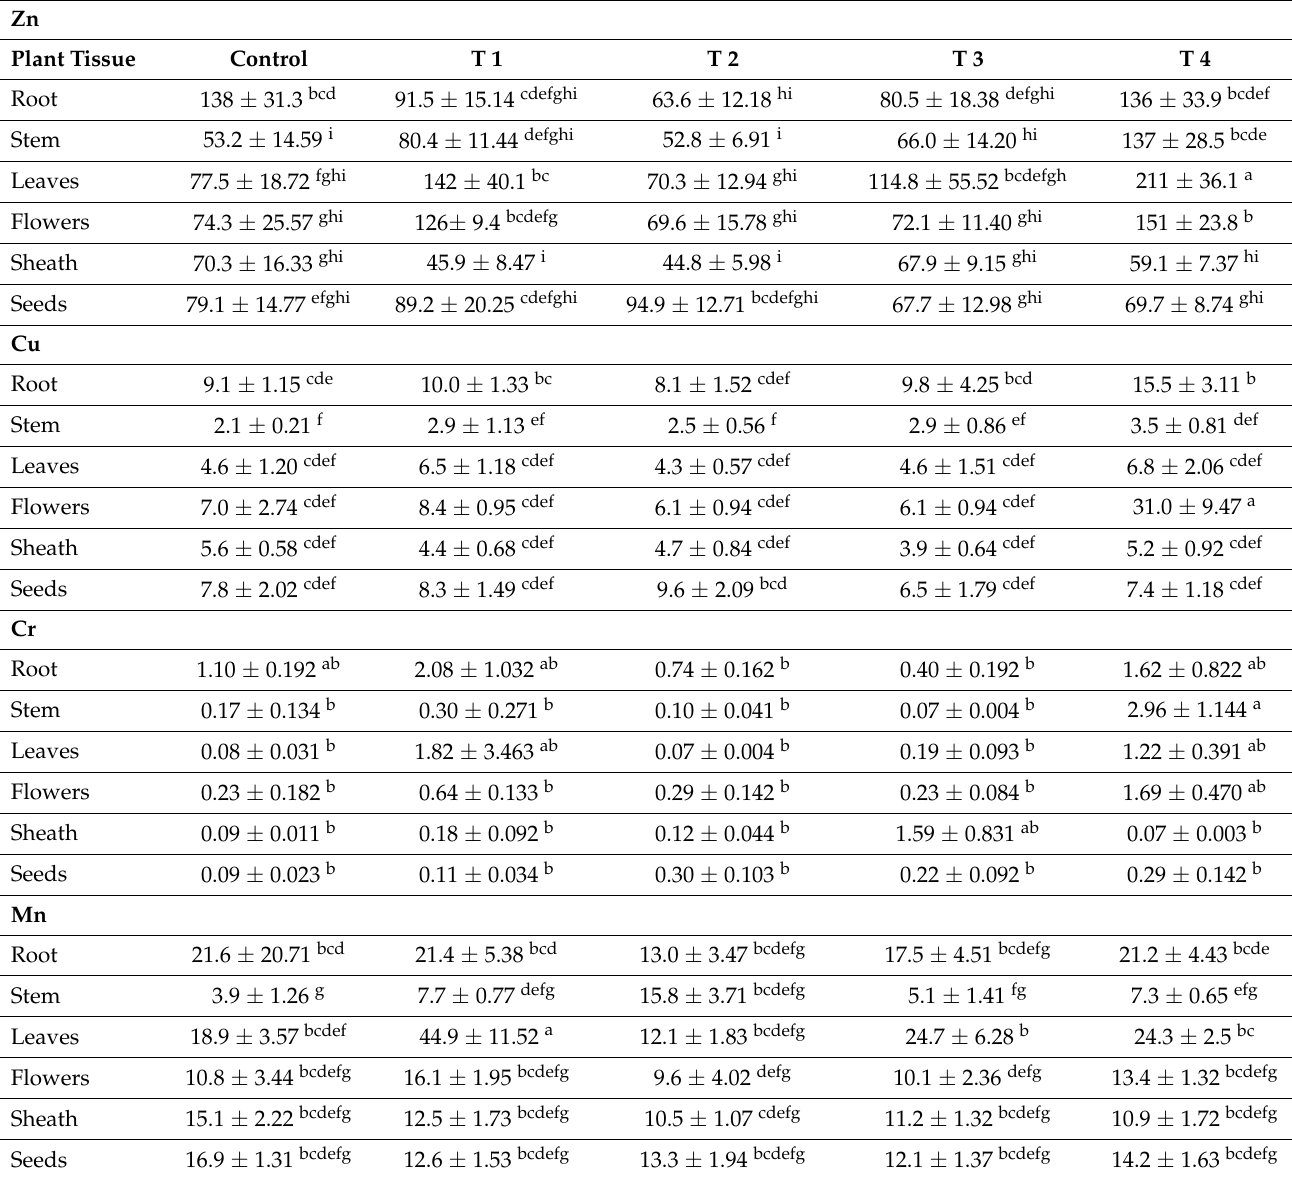
Table 7. Micronutrients accumulation in plant tissues of S. alba (mean ± SD, n = 6), mg kg − 1